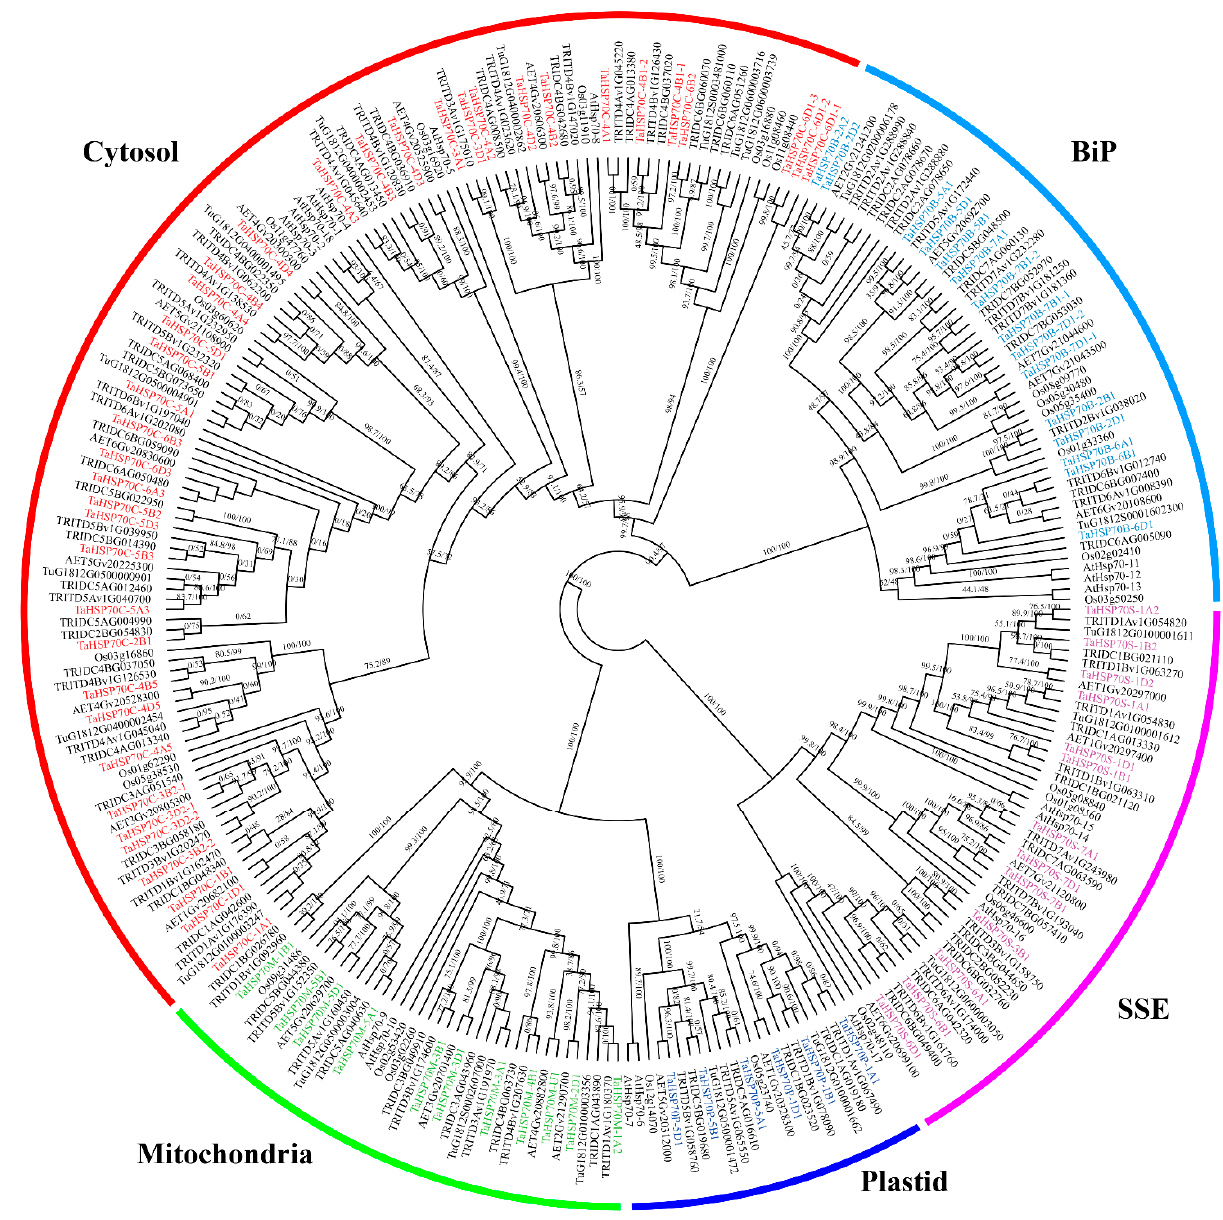
Figure 1. Maximum likelihood phylogenetic analysis of HSP70 proteins. HSP70s from Arabidopsis (At), rice (Os), T. urartu (Tu), Ae. tauschii (AET), wild emmer wheat (TRIDC), durum wheat (TRITD), and hexaploid wheat (Ta) were used for analysis. Values near branches represent the ultrafast bootstraps as well as the Shimodaira–Hasegawa approximate likelihood ratio test values. TaHSP70s in different subfamilies are shown with different colors.